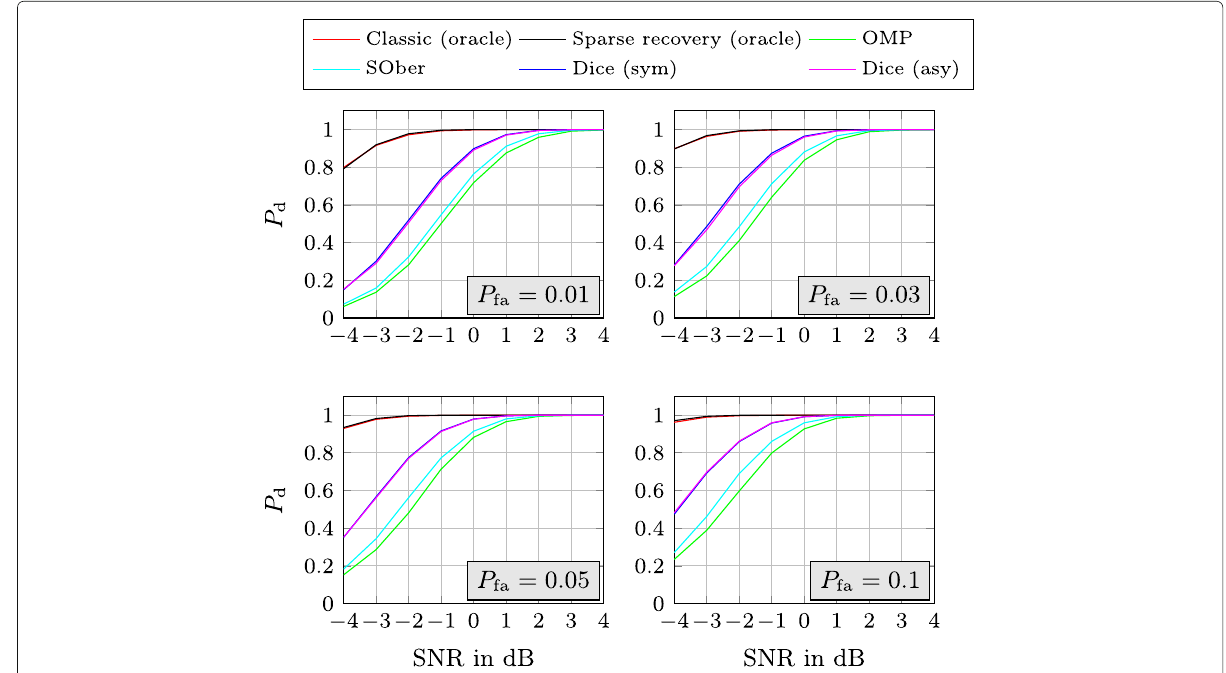
Fig. 2 Maximum detection rate (optimal individual consecutive sample ratio selection) over SNR for different false alarm